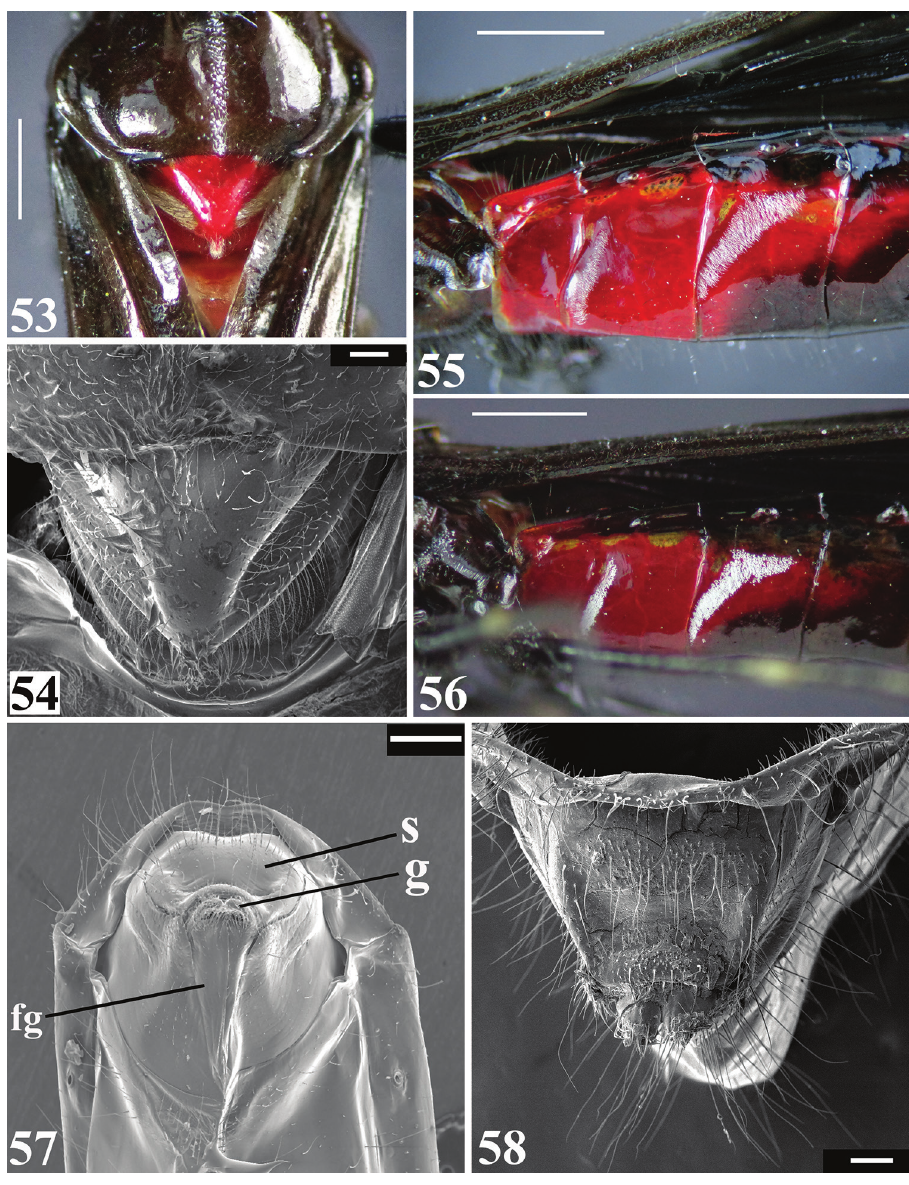
Figures 53–58. Parahiranetis salgadoi Gil-Santana, female. 53–54 dorsal view 53 posterior half of pronotum and scutellum 54 scutellum 55–56 abdominal segments II–IV, lateral view 55 patches of whitish, minute, thin, adpressed setae on midlateral portions of sternite III–IV without wax-like substance 56 the same with large amount of wax-like substance on setae 57–58 female genitalia 57 postero-ventral view ( fg : first gonapophysis; g : gonoplac; s : syntergite 9/10) 58 posterior view. Scale bars: 1.0 mm ( 53 ); 0.2 mm ( 54, 58 ); 2.0 mm ( 55–56 ); 0.5 mm ( 57